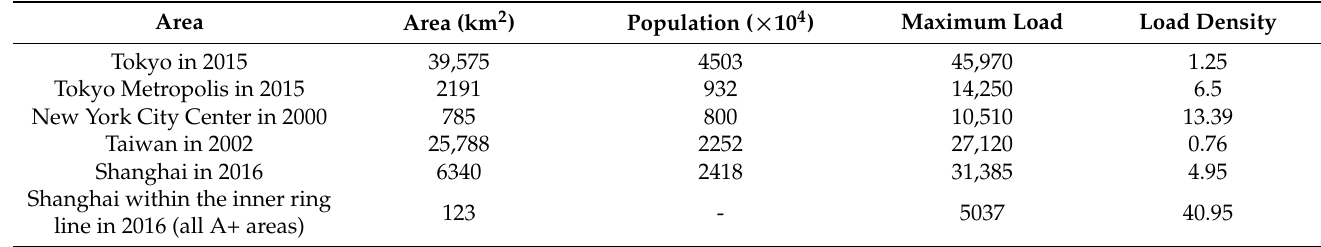
Table 7. Electricity consumption level of some countries and regions